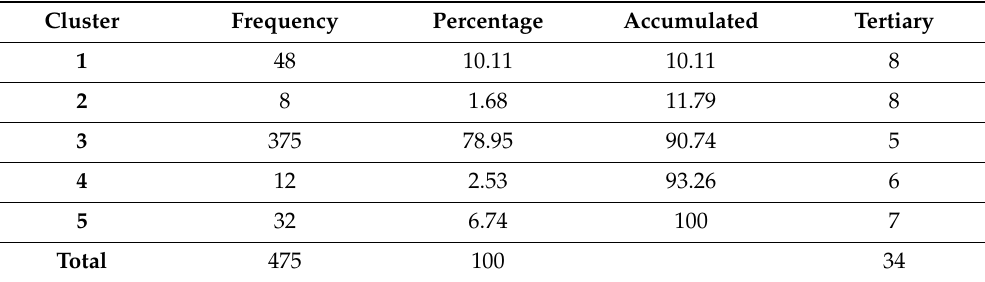
Table 2. Basic Data from the Cluster